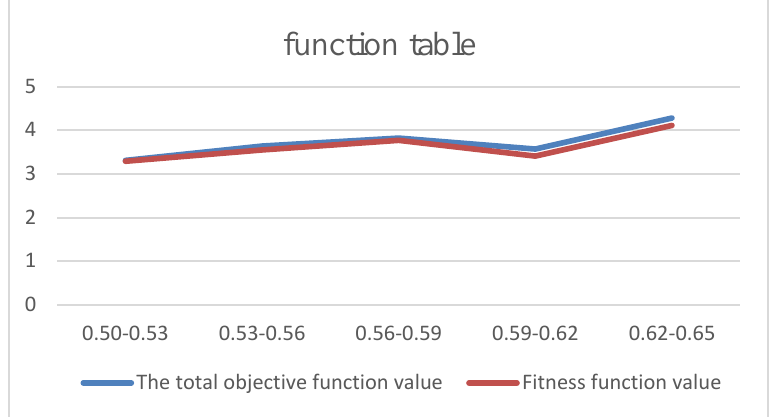
Fig. 2. Calculated results of different high-speed